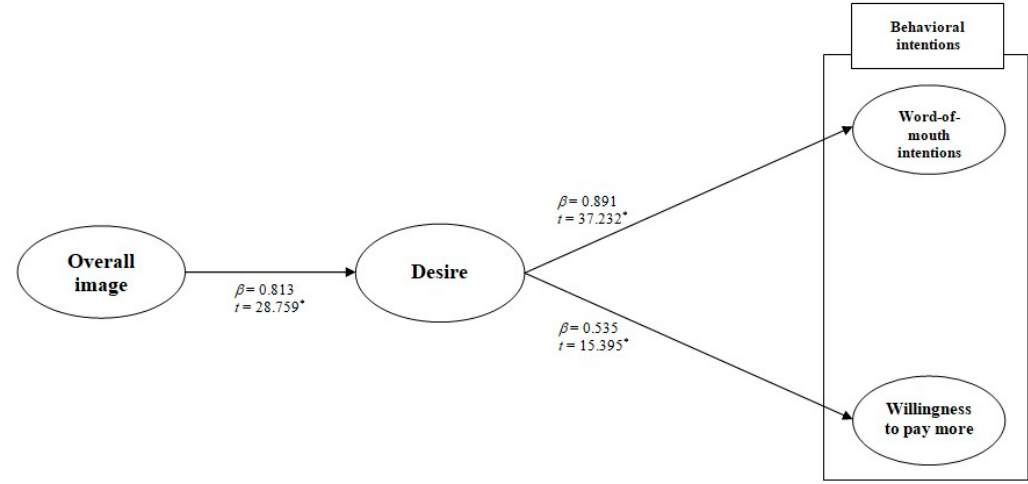
Figure 2. The standardized theoretical path coe ffi cients. Note: * p < 0.05